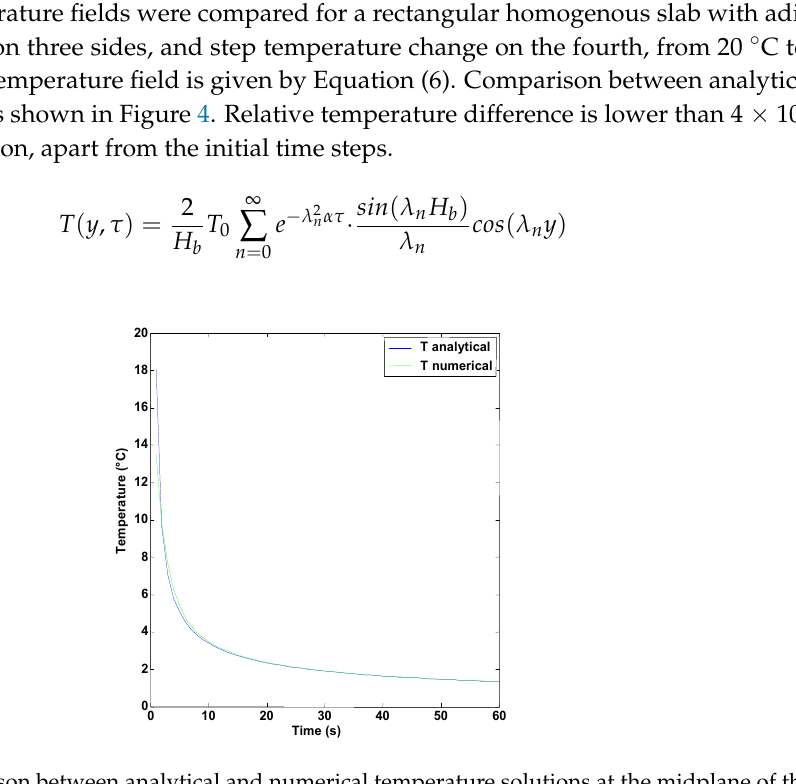
Figure 4. Comparison between analytical and numerical temperature solutions at the midplane of the slab for the first 60 s.